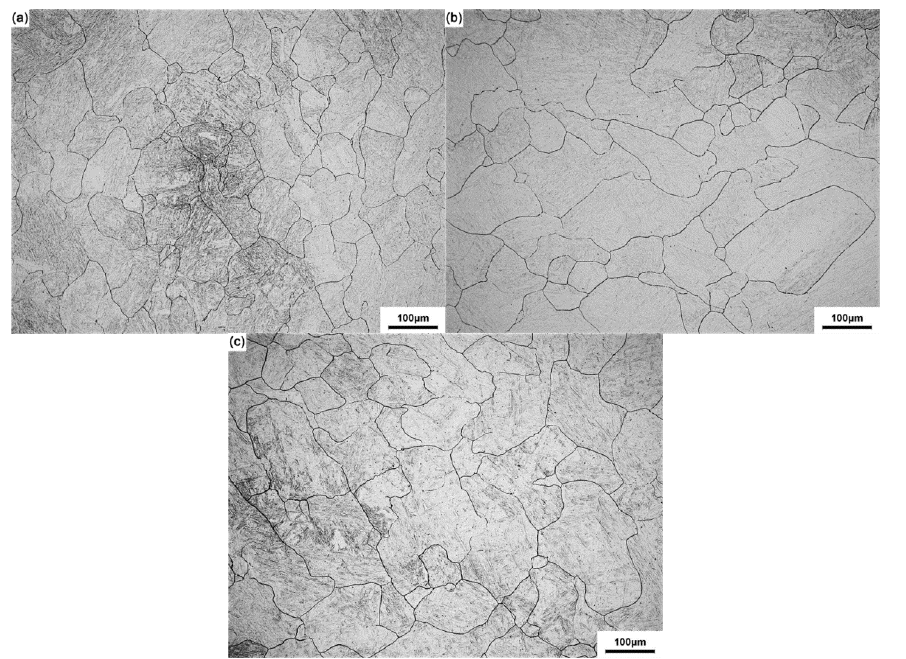
Figure 6. The optical microstructure of the 30Cr2Ni4MoV steel deformed at 1200 °C and 0.01 s −1 to strains of ( a ) 0.3; ( b ) 0.5; and ( c ) 0.7.